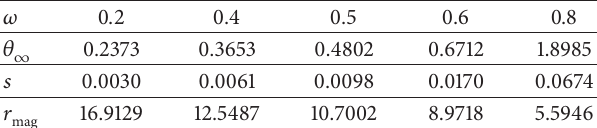
Table 1: Einstein rings and magnifications for 𝑛 = 1 .